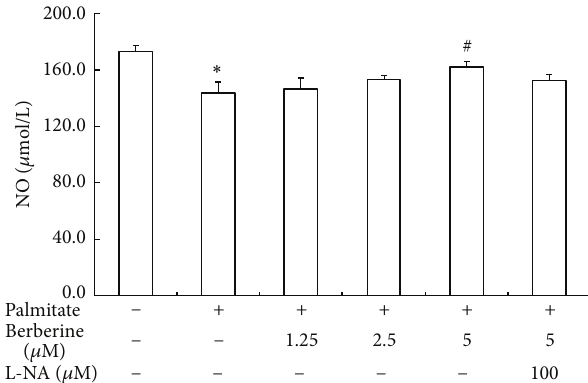
Figure 2: The effects of berberine on NO production in HUVECs exposed to palmitate. HUVECs were cultured in RPMI-1640 con- taining 0.5 mmol/L palmitate and treated with 1.25, 2.5, and 5 𝜇 mol/L berberine for 24h. The control group was not stimulated with 0.5 mmol/L palmitate. L-NA: N G -nitro-L-arginine. Data are expressed as mean ± S.E.M. ∗ 𝑃 < 0.05 versus control group, # 𝑃 < 0.05 versus palmitate treated